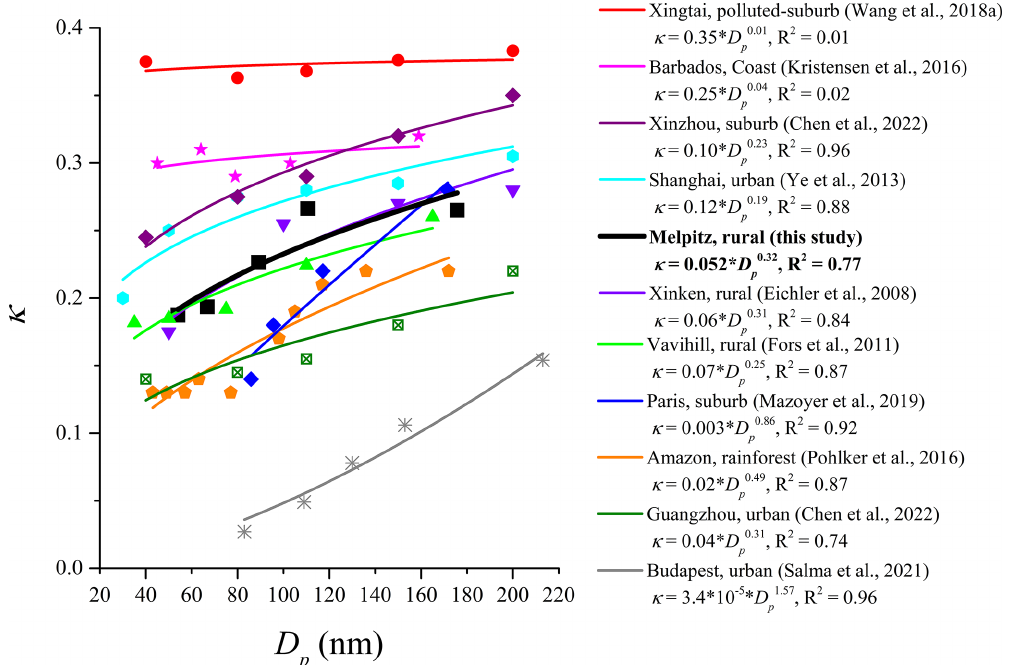
Figure 8. Relationships between the particle hygroscopicity factor ( κ ) and diameter ( D p ) observed at different stations. Lines are power-law fits of κ vs. D p